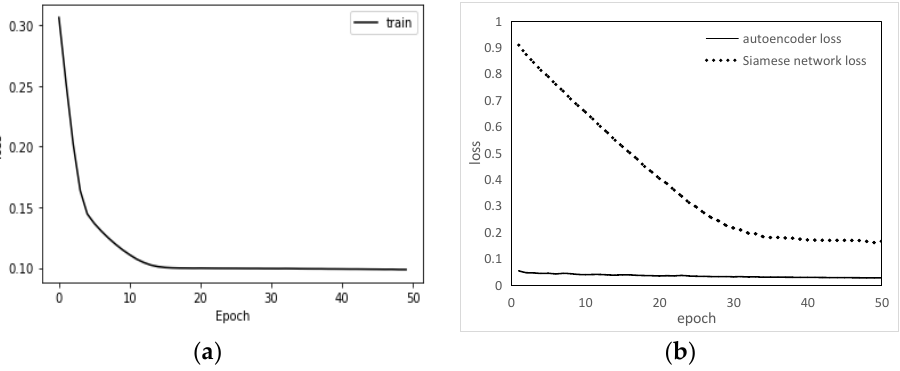
Figure 9. Model training process. ( a ) Stage 1 training loss curve and ( b ) Stage 2 training loss curve.